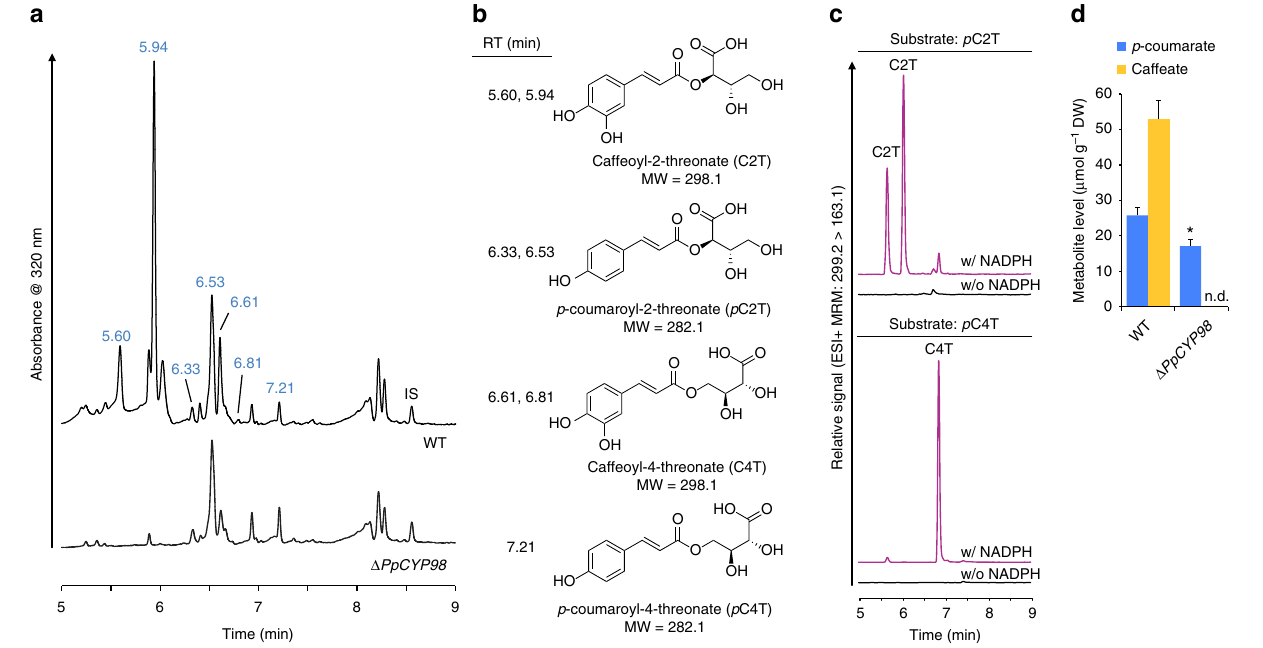
Figure 3 | PpCYP98 is a phenolic ring meta -hydroxylase and uses esters of threonic acid as substrates. ( a ) Ultraviolet chromatogram showing the absence of major peaks in the D PpCYP98 mutant gametophore crude extract. IS, internal standard (morin). ( b ) Names and structures of molecules at the indicated retention times (RT). ( c ) PpCYP98-dependent conversion of p -coumaroyl-2-threonate ( p C2T) and p -coumaroyl-4-threonate ( p C4T) esters into corresponding caffeoyl threonate esters (C2T and C4T). Control reactions without NADPH were concurrently analysed. Molecules were detected using dedicated multiple reaction monitoring (MRM) methods. Note that two caffeoyl-2-threonate isomers are produced from the two p -coumaroyl-2-threonate isomers present in the synthetic substrate, shown in Supplementary Fig. 6. ( d ) Acid hydrolysis of crude extracts demonstrates the total absence of caffeate in gametophores of the D PpCYP98 mutants. Results are the mean þ standard error from three independent biological samples for WT and three independent mutant lines. Asterisk indicates a significant difference between mutants and WT ( P -value ¼ 0.037; two-tailed Student’s t -test for samples of unequal variance).